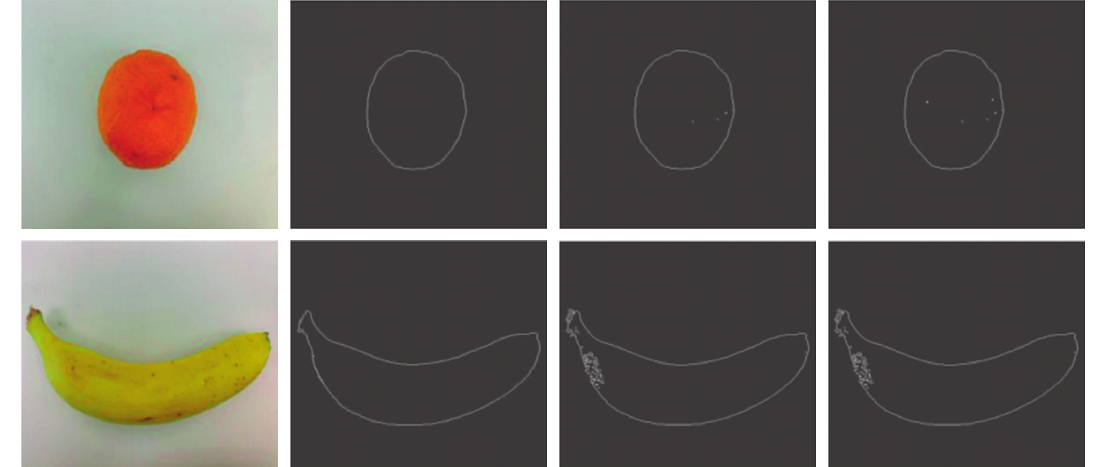
Figure 13: Shape detection.